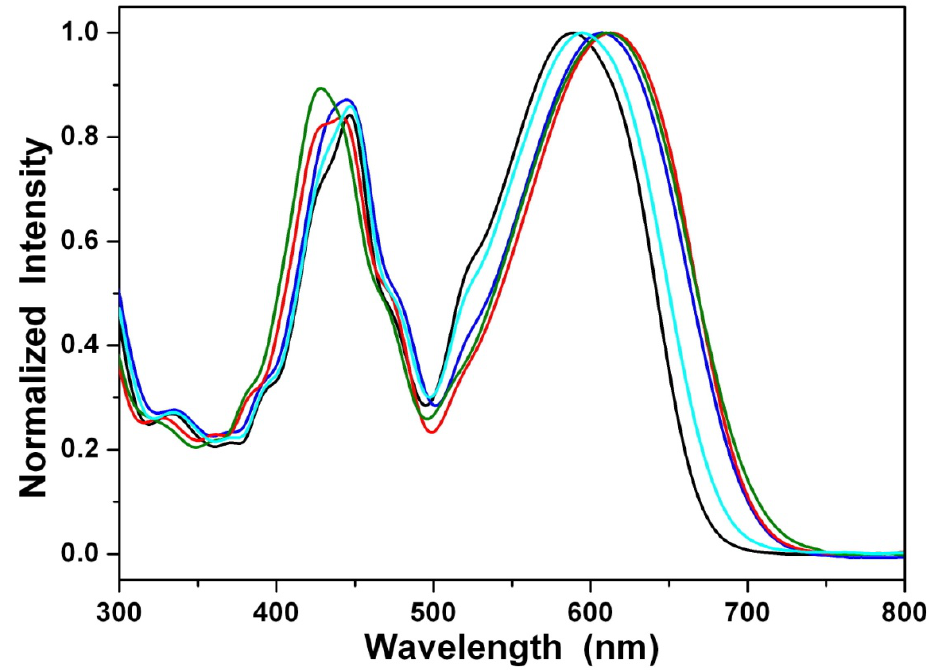
Figure 3. Normalized absorption spectra of 1a in cyclohexane (black line), diethyl ether (cyan line), ethyl acetate (blue line), dichloromethane (green line) and acetonitrile (red line).